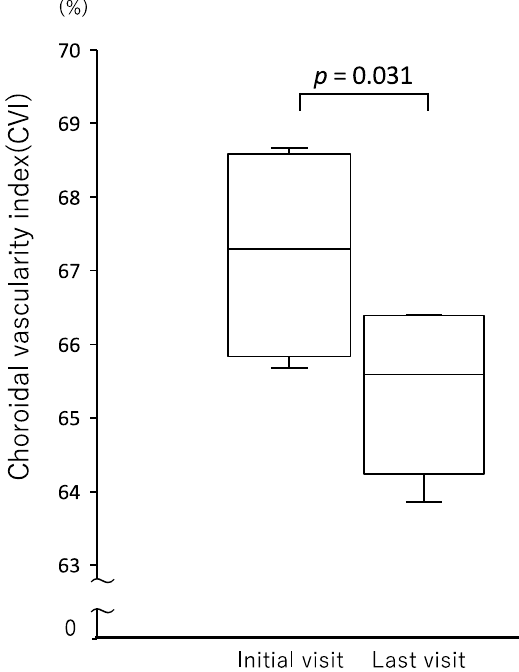
Figure 3. CVI, the ratio of luminal area to choroidal area, was compared between the initial and last visit. CVI was significantly lower at the last visit than at the initial visit.